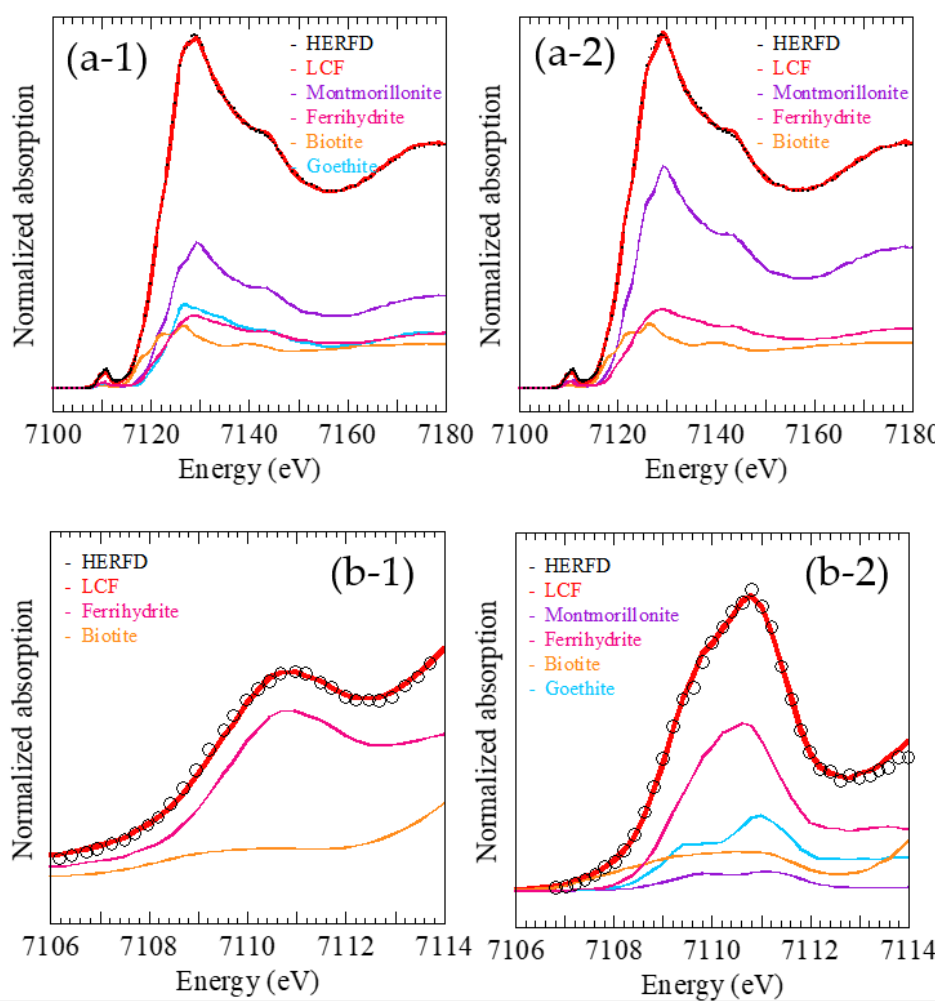
Figure 4. Fe K-edge XANES spectra for Fe in MT21-S2: ( a-1 ) LCF for HERFD-XANES with four endmembers and ( a-2 ) three endmembers; ( b-1 ) LCF for pre-edge region of normal XANES and ( b-2 ) HERFD-XANES. Circles: measured spectra; solid curve: fitted spectra.